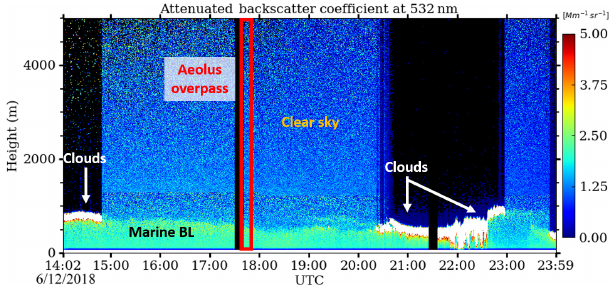
Figure 6. Time–height plot of the attenuated backscatter coefficient at 532nm around the time of the Aeolus overpass (red rectangle)